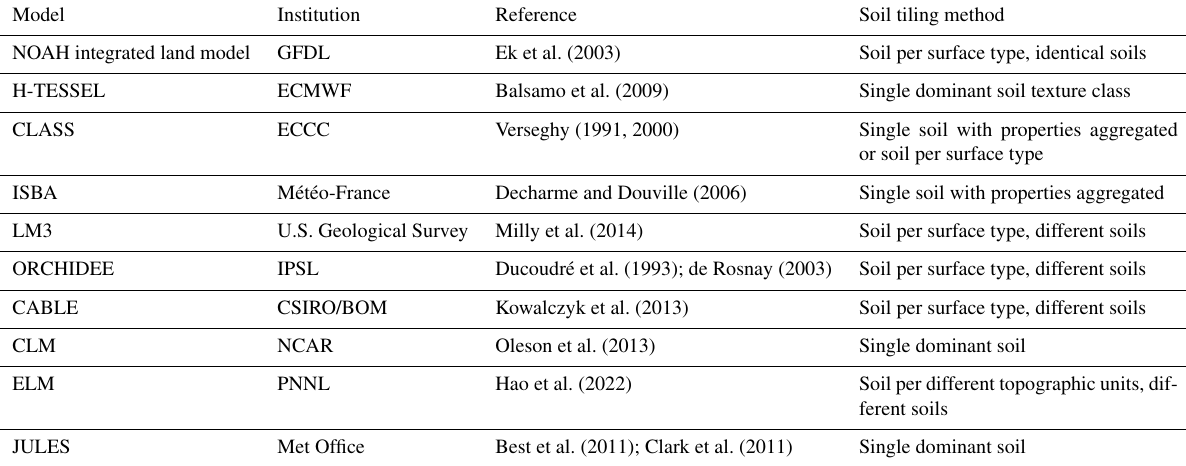
Table 1. Examples of currently used land surface models with their methods for representing sub-grid-scale soil heterogeneity.